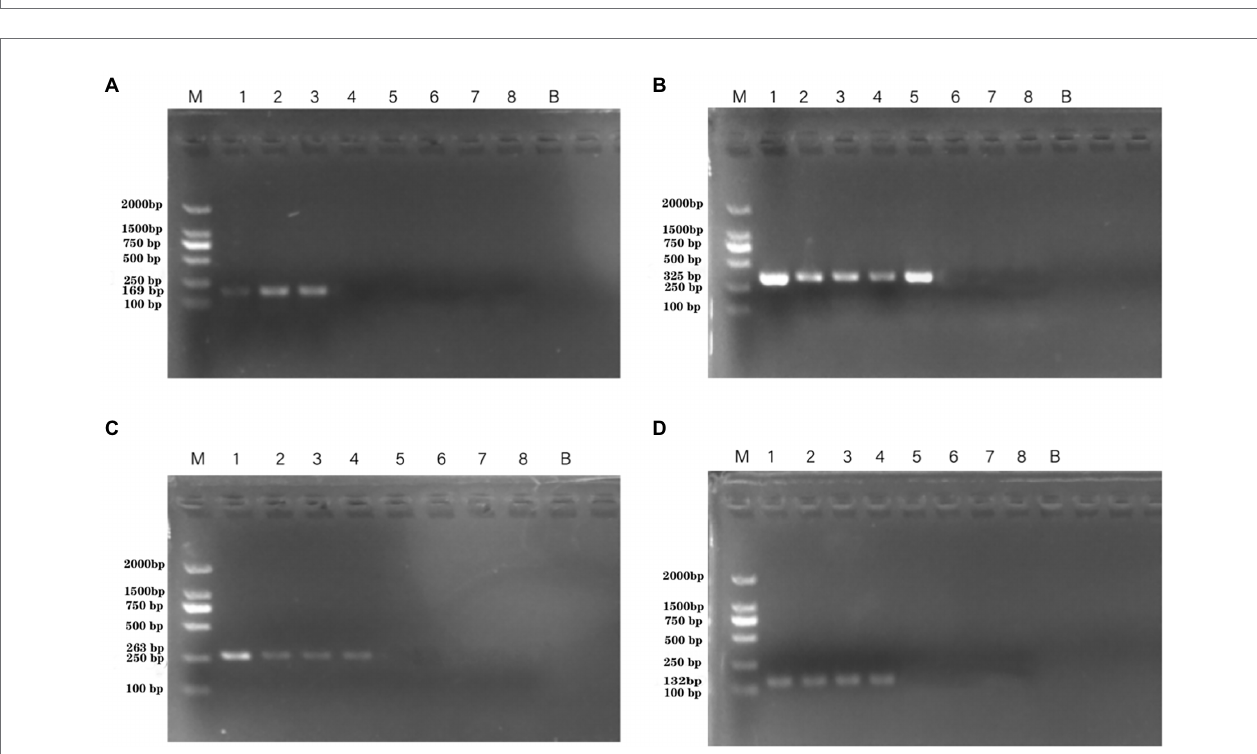
FIGURE 5 | PCR detection sensitivity using dilutions of a pure culture of P. aeruginosa ATCC 15442 in spiked tomato lane M = DSTM 2000 marker (Dongsheng Biotechnology, Guangdong, China); lane N = negative control (double-distilled H 2 O); and lanes 1–8 = 1.33 × 10 8 CFU/ml, 1.33 × 10 7 CFU/ml, 1.33 × 10 6 CFU/ml, 1.33 × 10 5 CFU/ml, 1.33 × 10 4 CFU/ml, 1.33 × 10 3 CFU/ml, 1.33 × 10 2 CFU/ml, and 2 × 10 1 CFU/ml, respectively. (A) Primer set PA1 (169 bp); (B) primer set PA2 (325 bp); (C) primer set PA3 (263 bp); and (D) primer set PA4 (132